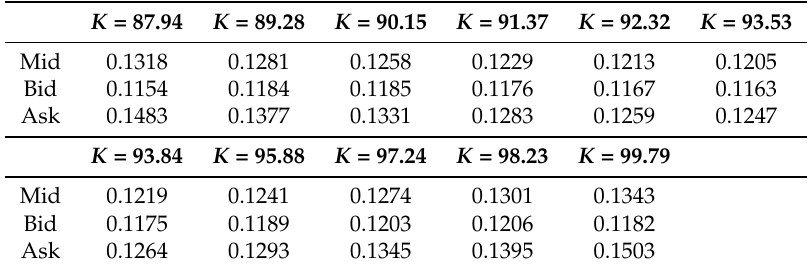
Table 3. Implied volatilities of 1-month option data on the FX